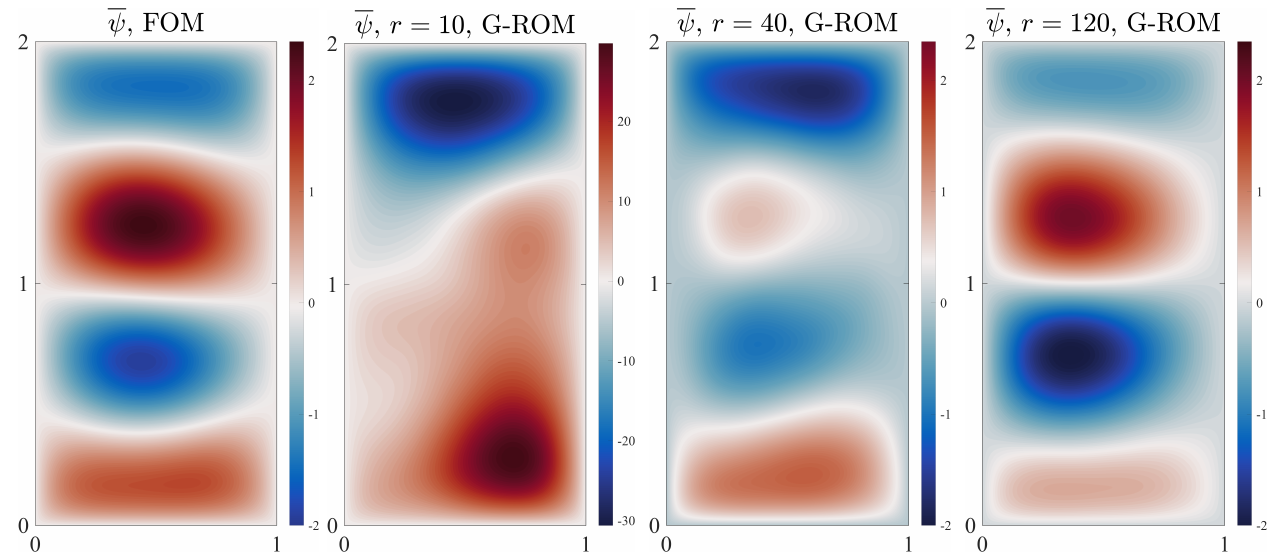
Figure 9. Resolved, reconstructive regime. Time-averaged streamfunction, ψ , for FOM and G-ROM with r = 10,40, and